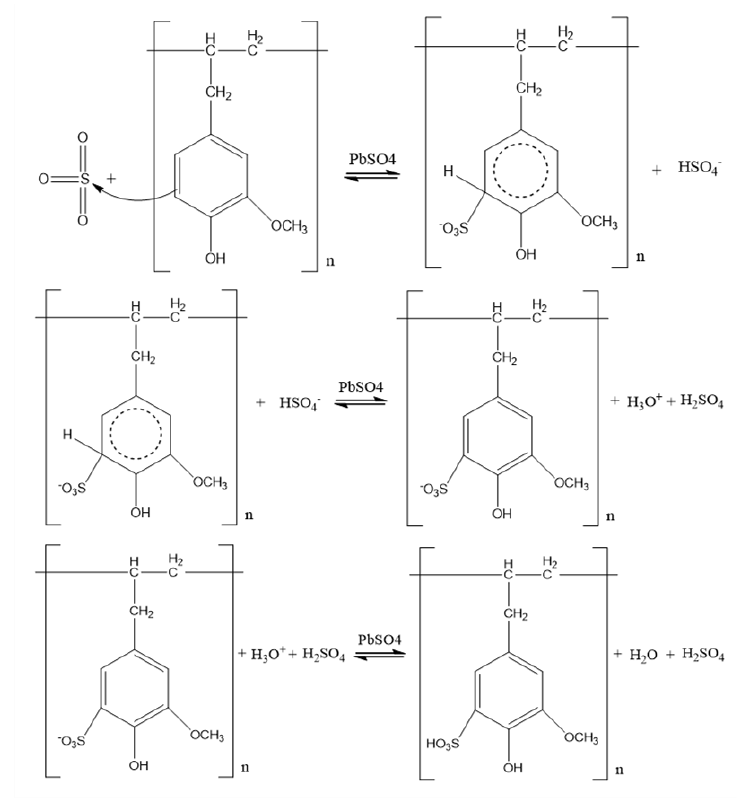
Figure 3. Sulfonation mechanism of polyeugenol.